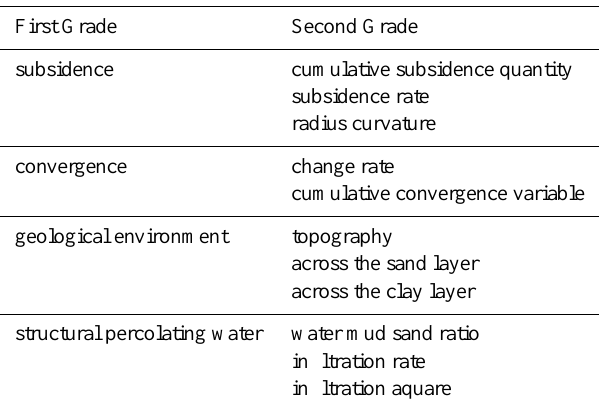
Table 1. Evaluation indexes system of metro